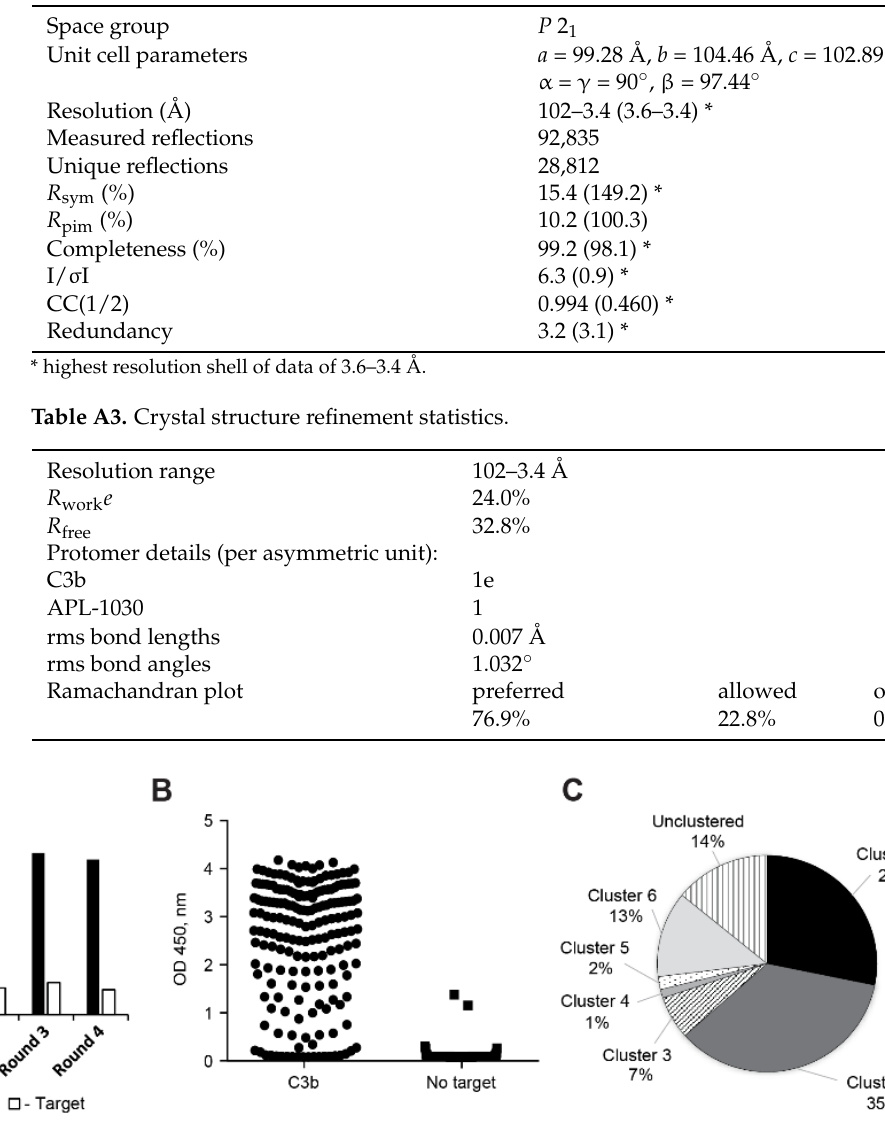
Figure A1. ( A ) Nanofitin (in pAFG12) enrichment by ribosome display, ( B ) ELISA screening for C3b binders, and ( C ) proportion of Nanofitin sequences grouped into clusters based on the homology of their binding site. OD, optical density.